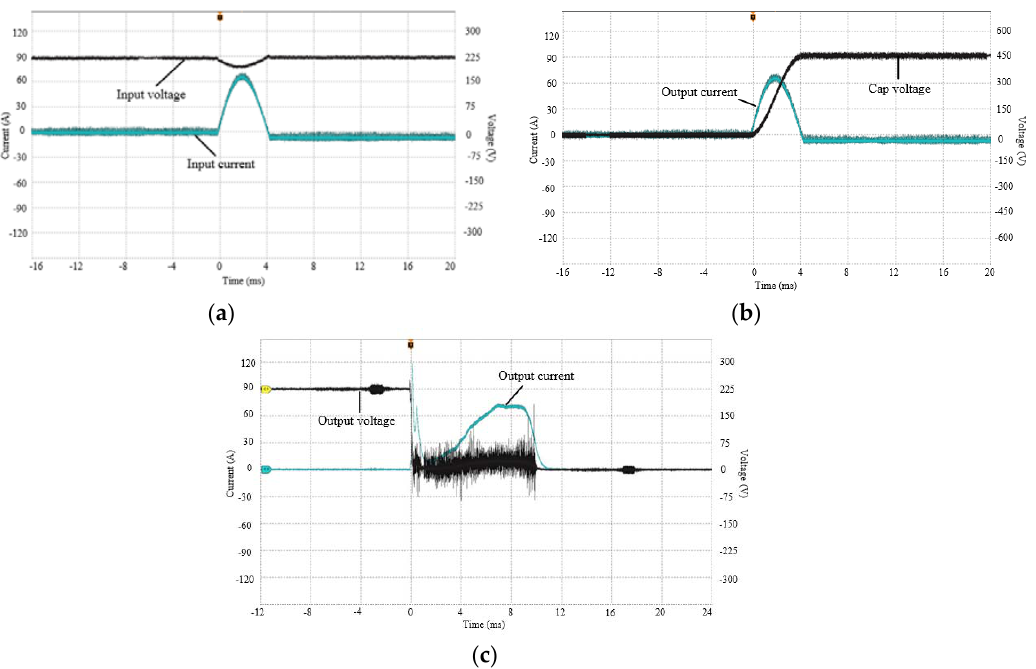
Figure 12. Experimental waveforms: ( a ) waveforms of input voltage and output current (time: 4 ms/div; voltage: 75 V/div; current: 30 A/div); ( b ) waveforms of Cap voltage and output current (time: 4 ms/div; voltage: 150 V/div; current: 30 A/div); ( c ) output voltage and output current waveforms of mechanical circuit breaker ( MCB) at short ‐ circuit instant (time: 4ms/div; voltage: 75 V/div; current: 30 A/div).